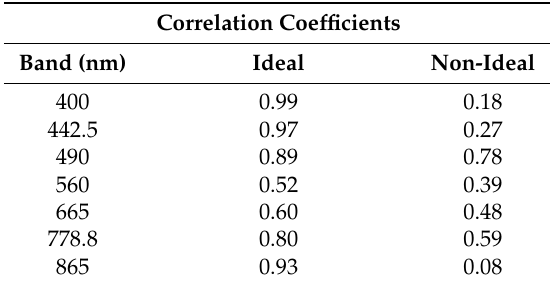
Figure A1. Error correlation between L OLCI , u , L OLCI , d and ρ in the water-leaving radiance measurement equation observed in the Monte Carlo analysis for cast 1 only. Table A2. Pearson correlation coefficients between the L OLCI , u and L OLCI , d errors for all seven bands for cast 1 only.